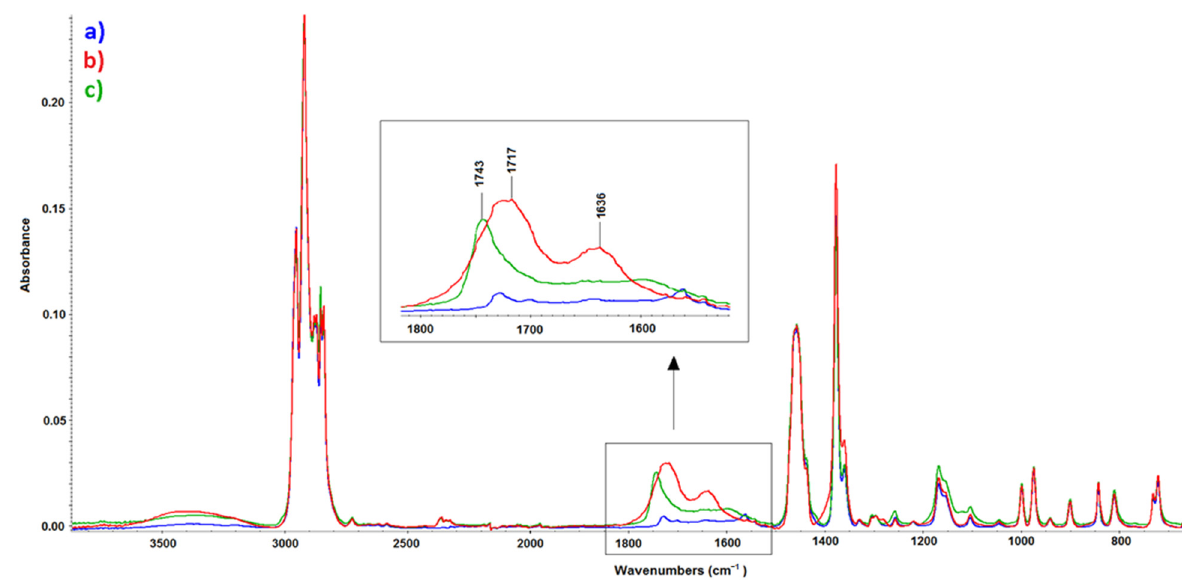
Figure 9. Infrared spectra of ( a ) PP, untreated, ( b ) PP, after plasma treatment (8 W), and ( c ) PP, after β − radiation treatment (99 kGy).